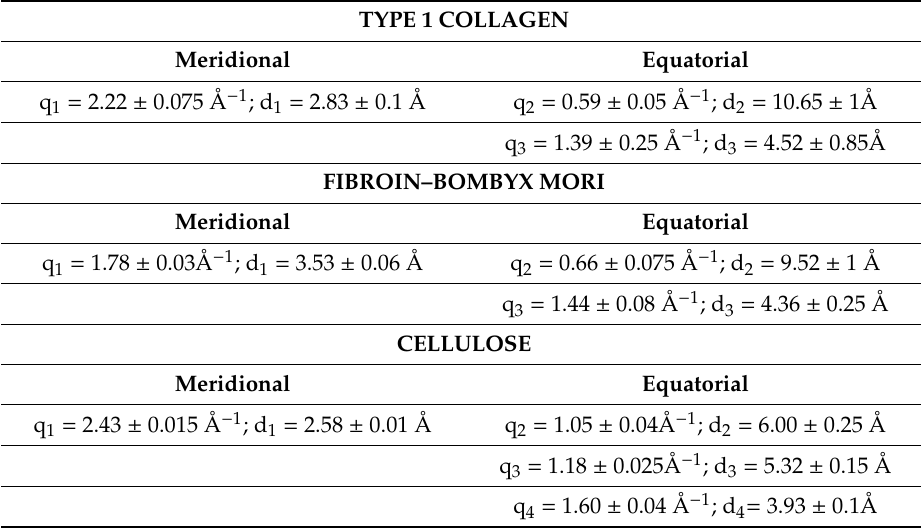
Table 1. Positions and relative interplanar distances extracted from the 1D-WAXS data reported in Figure 3 (TYPE 1 COLLAGEN), Figure 4 (FIBROIN − BOMBYX MORI) and Figure 5